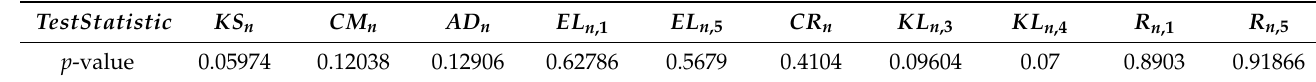
Table 9. p -values for the COVID-19 data of